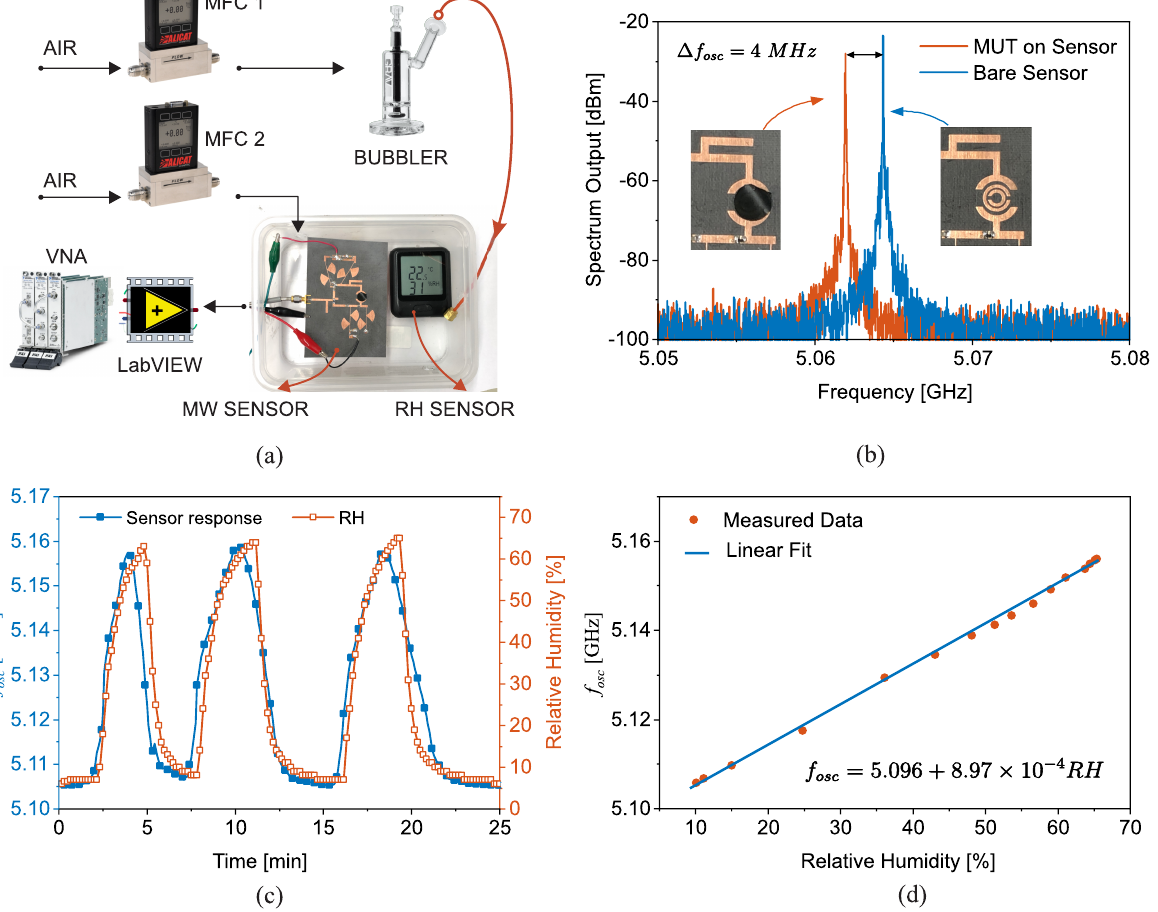
Figure 17. Relative humidity sensor with an immobilizing analyte and sensor response. ( a ) Sensing setup for measuring relative humidity using an oscillator. ( b ) Spectrum output showing the effect of PVA/PANI. ( c ) Cyclic relative humidity measurement and its coherence with the sensor response. ( d ) Calibration curve: oscillation frequency correlation vs. the relative humidity. Reprinted with permission from Ref.